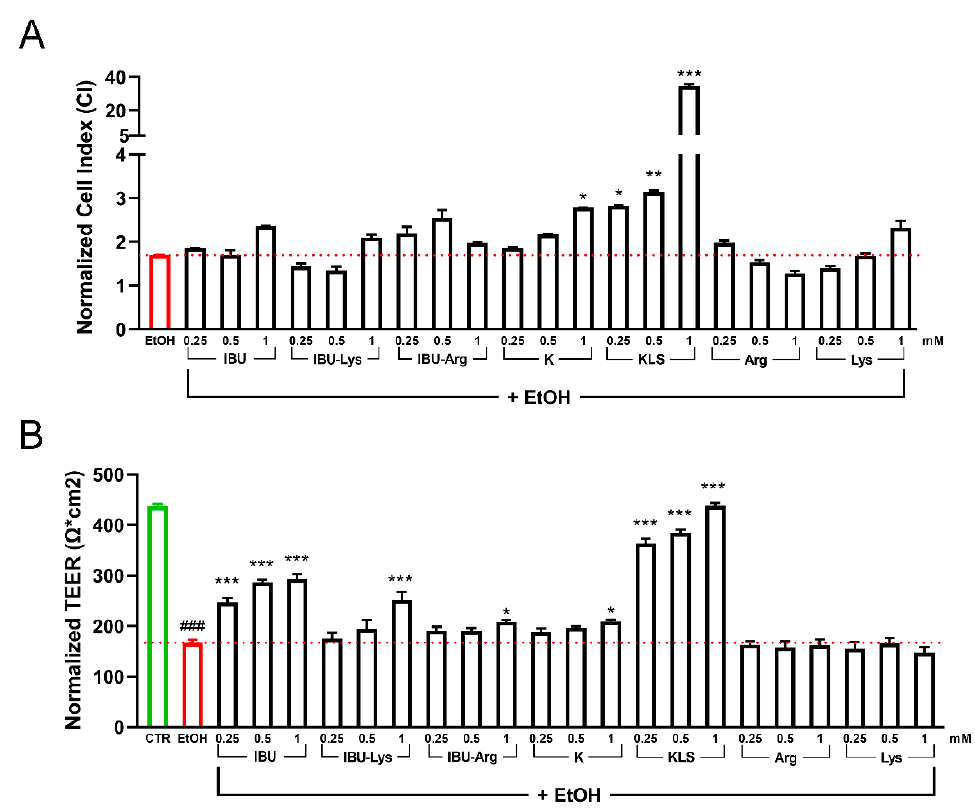
Figure 1. ( A ) Cell index analysis for Caco-2 cultured 20 DIV, treated with 6% EtOH for 24 h and then with the tested NSAIDs and corresponding salts (0.25 mM, 0.5 mM, and 1 mM for 72 h). Data are reported as Normalized Cell index. ( B ) TEER analysis for Caco-2 cultured for 20 DIV, treated with EtOH 6% for 24 h, and then with the tested NSAIDs (0.25 mM, 0.5 mM, and 1 mM for 72 h). Data are reported as Normalized TEER. Data are mean ± SD of 3 different experiments. One way ANOVA was performed: ***, p < 0.0001; **, p < 0.005; *, p < 0.05 vs. EtOH; ###, p < 0.0001 EtOH vs. CTR.